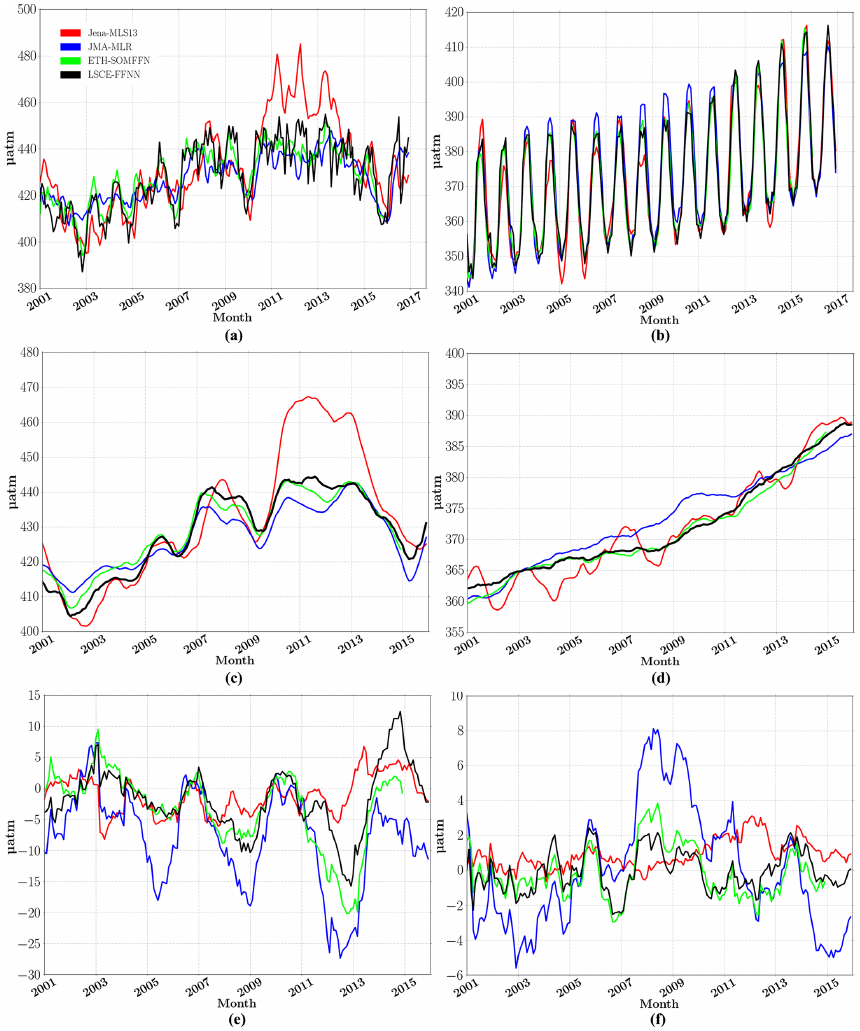
Figure 5. Surface ocean p CO 2 in the equatorial East Pacific (biome 6) ( a, c, e ) and the subtropical permanently stratified North Atlantic (biome 11) ( b, d, f ): FFNN (black), JMA (blue), Jena (red) and ETH-SOMFFN (green). (a, b) The monthly time series averaged over the biome. (c, d) The 12-month running mean averaged over the biome. (e, f) The yearly p CO 2 mismatch (difference between the mapping methods and the SOCAT